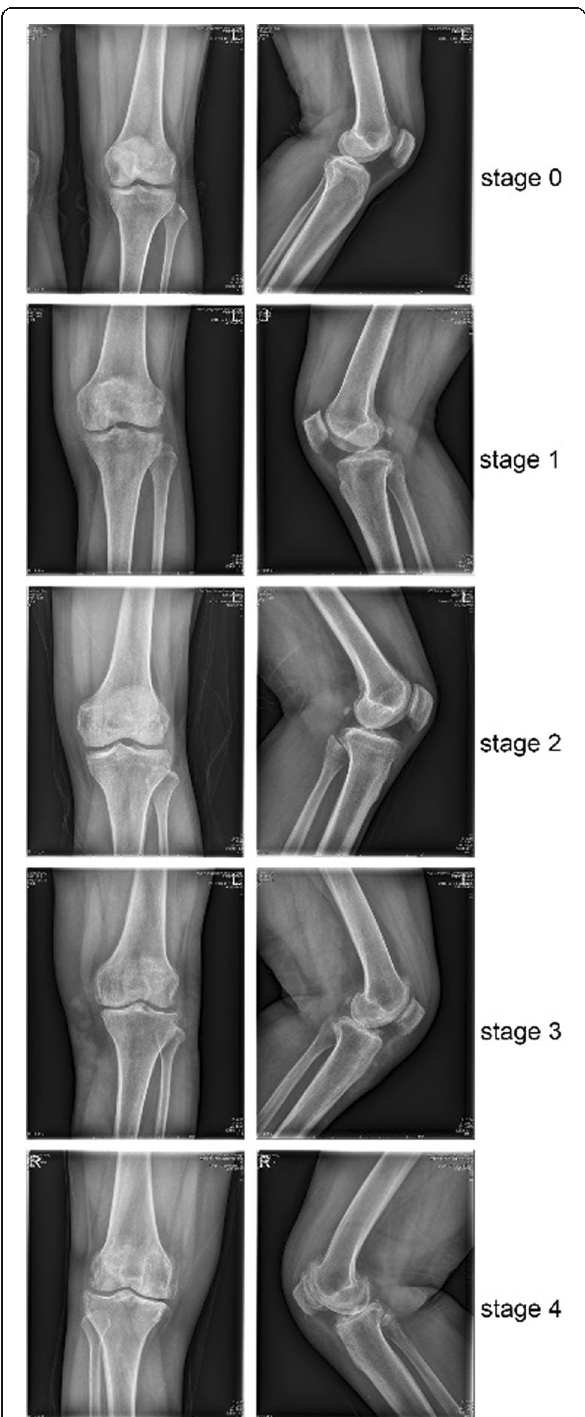
Fig. 1 Representive photos of different severity of knee OA based on Kellgren-Lawrence (K&L) scale (from stage 0 to stage 4)